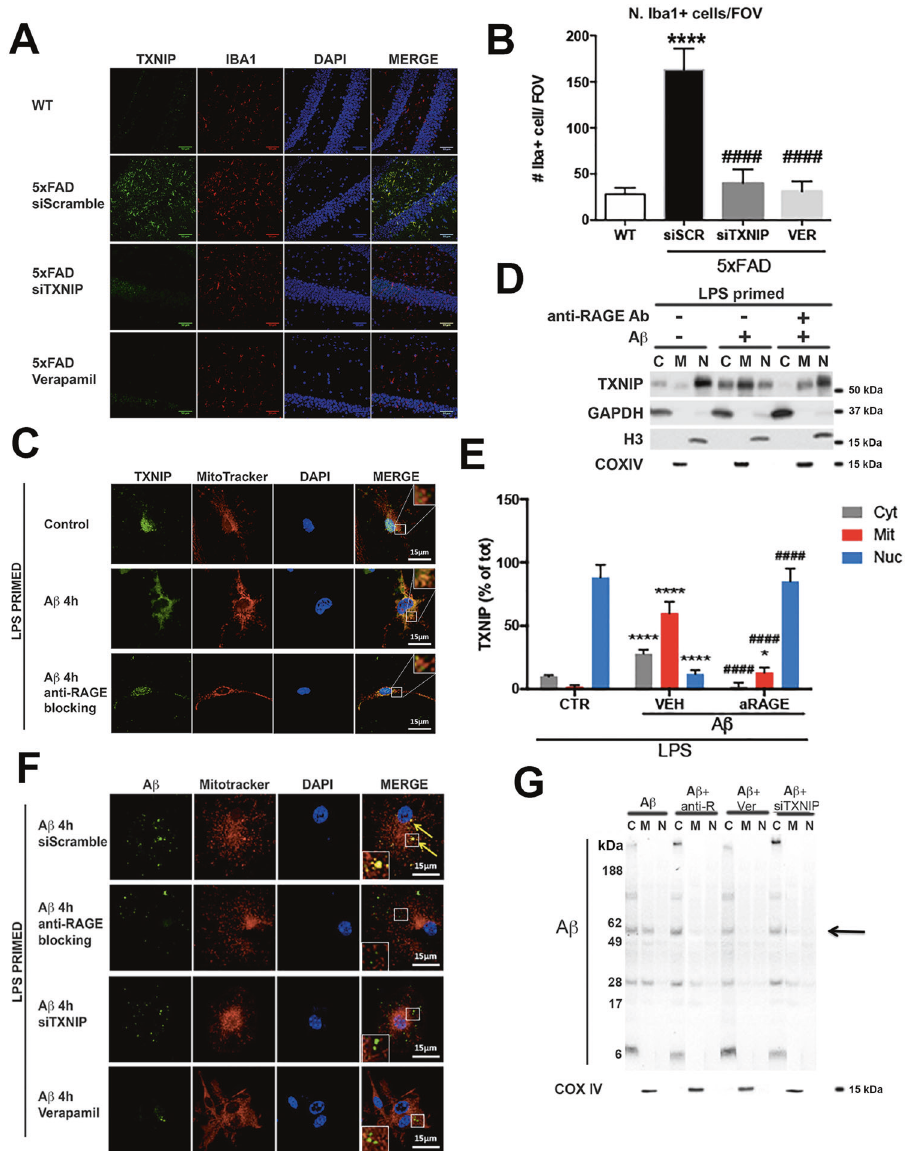
Fig. 2 RAGE – TXNIP axis role in A β -promoted microglia dysfunction. A IHC analysis of TXNIP (green) and Iba1 (red) in 4 m old control and 5xFAD mice hippocampus treated as indicated. Nuclei are in blue (representative of n = 4). B Quanti fi cation of Iba1 positive microglia, expressed as cells per fi eld of view (FOV) in WT and 5xFAD mice (Tg) treated as indicated. One-way ANOVA followed by Tukey ’ s multiple comparison test (**** p < 0.0001 versus WT mice, #### p < 0.0001 versus 5xFAD mice treated with scrambled shRNA, n = 4). C IF analysis of TXNIP (green) and mitochondria (red), nuclei are in blue, in microglia treated as indicated ( n = 5). D , E Subcellular fractionation, western blot analysis ( D ) and quanti fi cation ( E ) of TXNIP, GAPDH (cytoplasm), histone H3 (nucleus), Cox IV (mitochondria). One-way ANOVA followed by Tukey ’ s multiple comparison test ( n = 5; **** p < 0.0001 versus control cells; #### p < 0.0001 versus cells treated with A β ). F IF analysis of A β (green) and mitochondria (red) in microglia treated as indicated. Nuclei are in blue (representative of n = 5). G Subcellular fractionation and western blot of A β oligomers and Cox IV (representative of n =